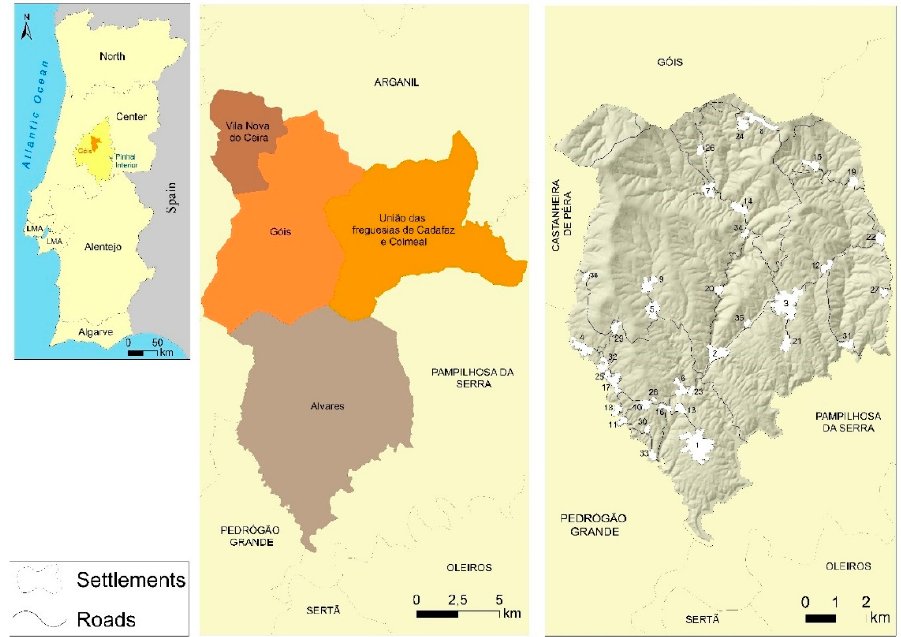
Figure 1. Location of the Alvares civil parish, in the south part of the Góis municipality, which belongs to the sub-region of Pinhal Interior, in central Portugal. On the right, the location of the 36 settlements in Alvares.